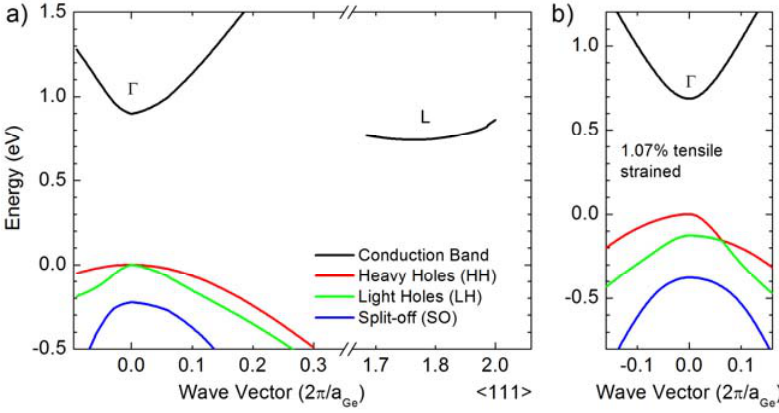
Figure 1. ( a ) Electronic band structure of unstrained bulk Ge along the (111) direction; · p calculation of 1.07% tensile strained ( b ) eight ‐ band k ∙ p calculation of 1.07% tensile strained Ge. k